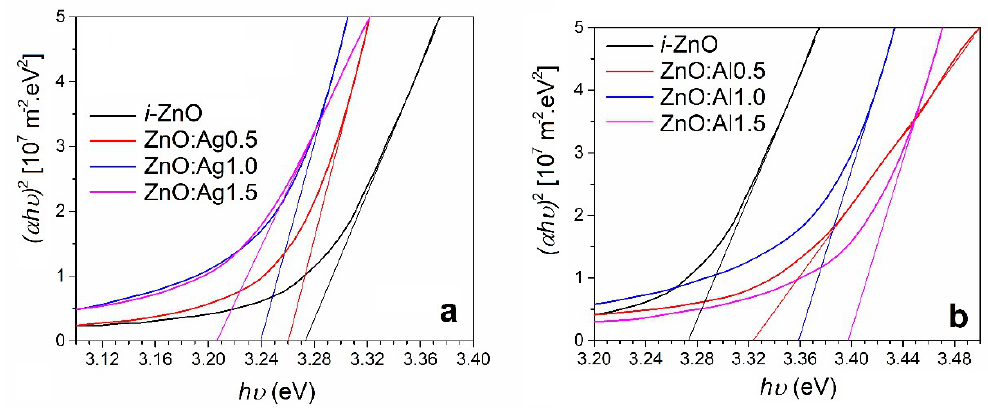
Figure 6. ( α h ν ) 2 - h ν graphs for different ZnO based films to estimate the band gap energy ( E g ) values: ( a ) Ag-doped ZnO films and ( b ) Al-doped ZnO films.